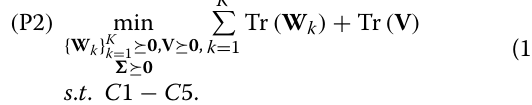
algorithm designs. Based on the analysis of the secrecy rates and CSI in above paragraphs, the first consid- ered optimization problem minimizing the UL